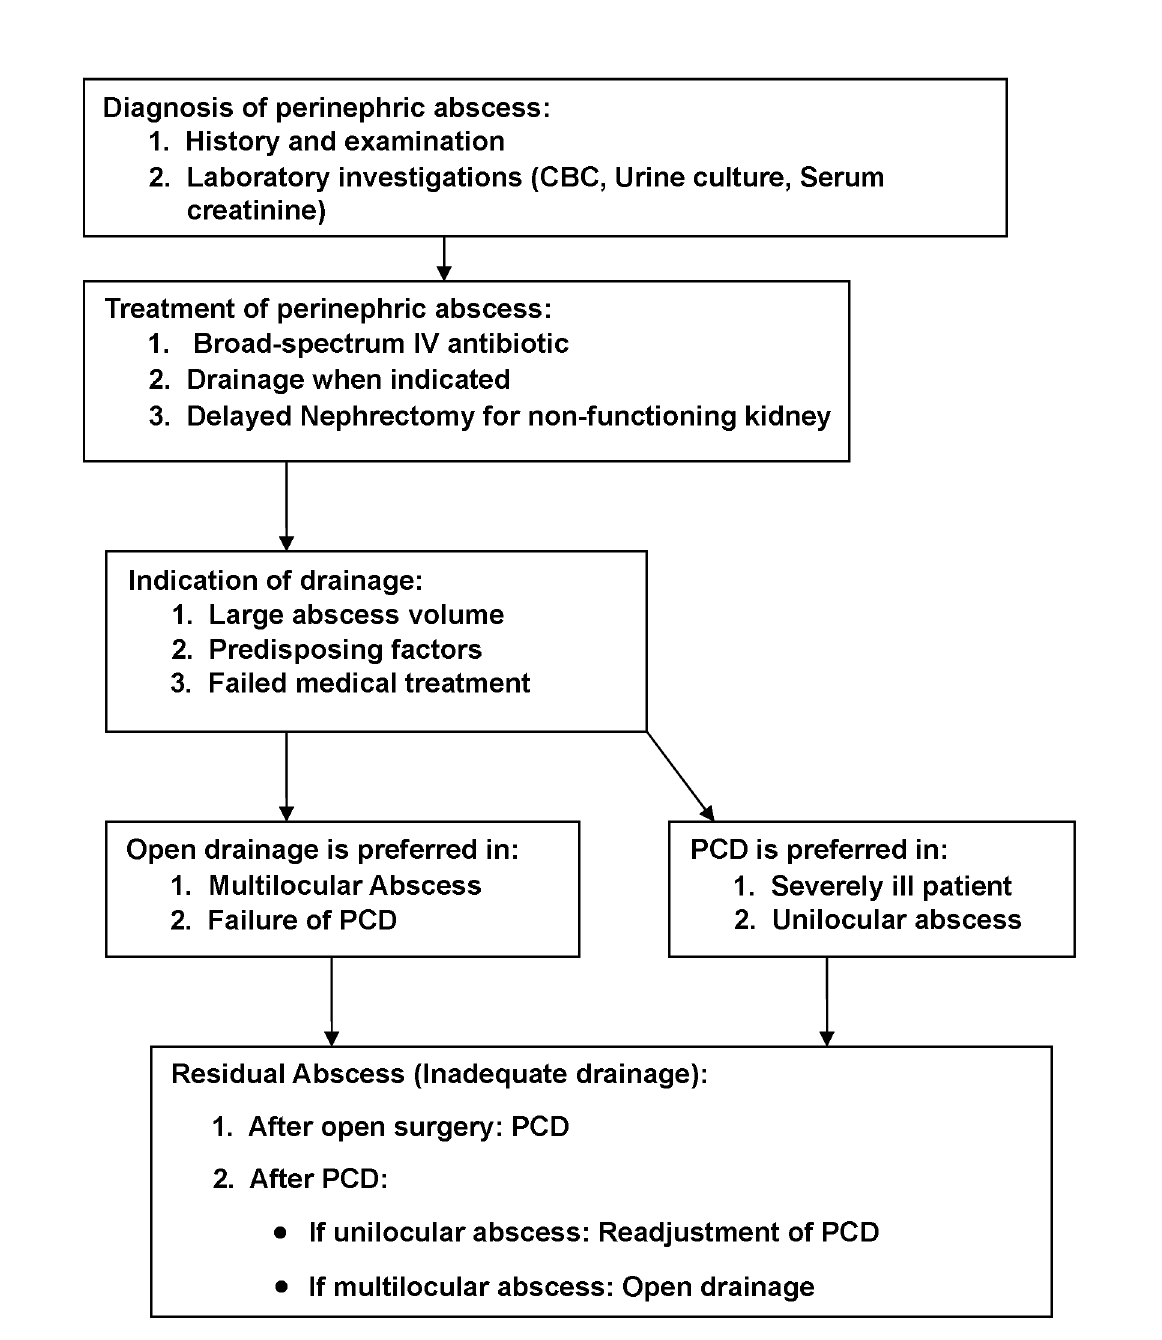
Figure 1 – Algorithm for management of perinephric abscess. PCD = percutaneous tube drain; CBC= complete blood